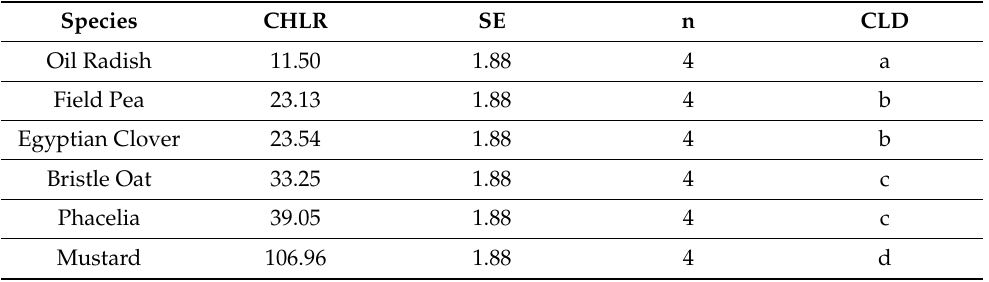
Table A1. Comparison of mean canopy height derived from low-resolution UAV-mission (CH LR ) of the different species grown in the field experiment, standard error (SE), and compact letter display (CLD) indicating significant differences among the species according to Tukey’s test at p < 0.05). Species CHLR SE n CLD Oil Radish 11.50 1.88 4 a Field Pea 23.13 1.88 b Egyptian Clover 23.54 1.88 Bristle Oat